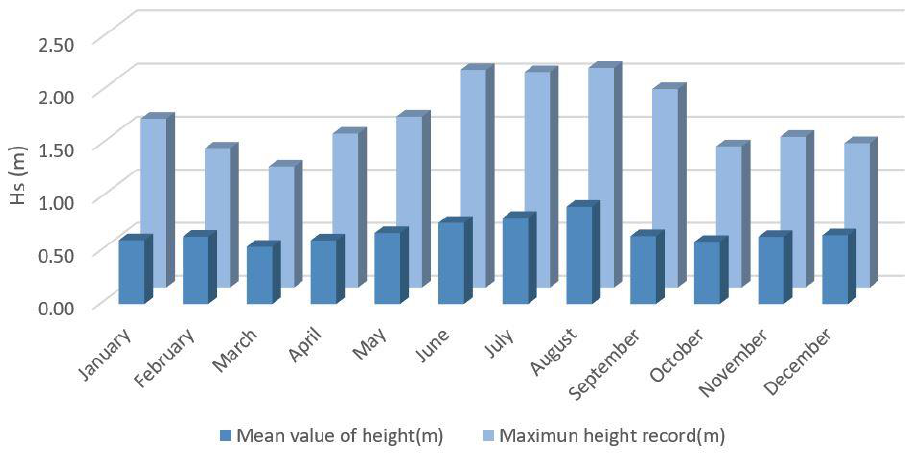
Figure 8. Mean and maximum monthly values of significant height (Hs).